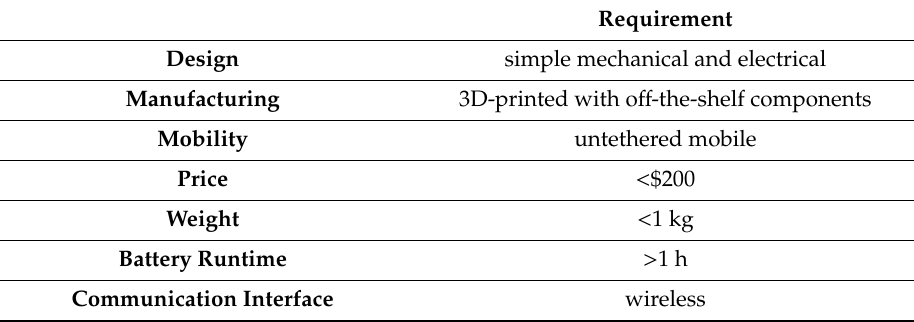
Table 1. Requirements for the robotic hand exoskeleton.